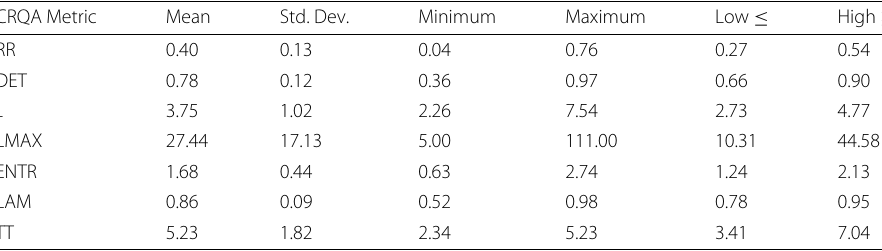
Table 3 Descriptive values of the CRQA metrics in the case-level analysis ( N = 376) CRQA Metric Mean Std. Dev. Minimum Maximum